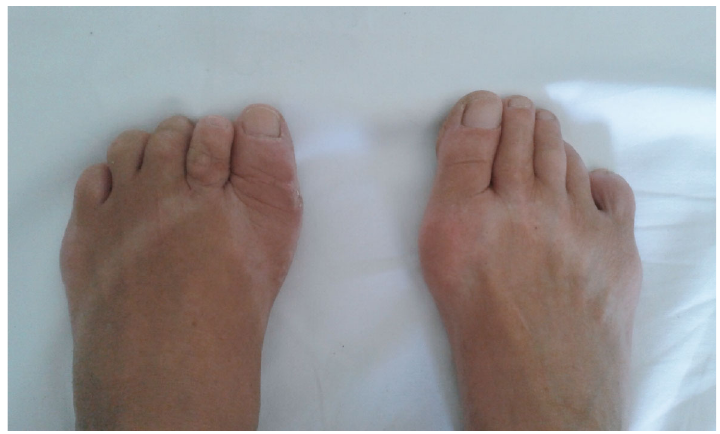
Figure 6: Photograph of both of the patient ’ s feet three months after the